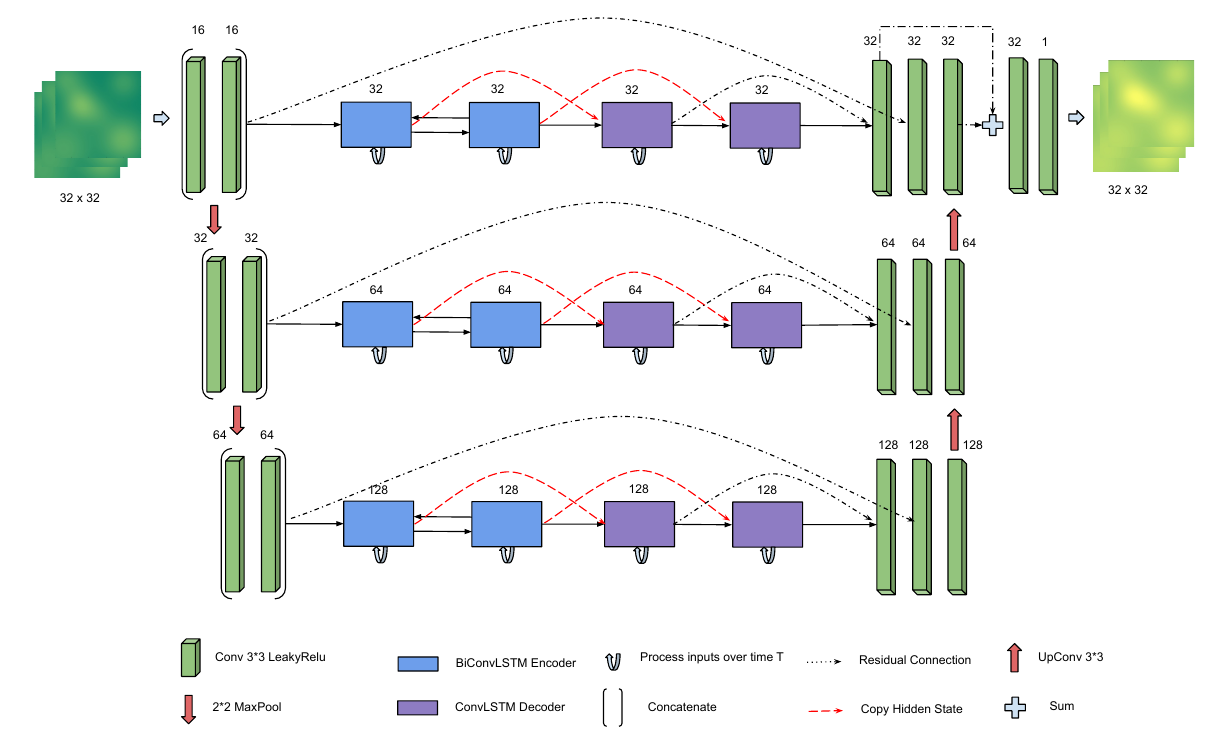
Figure 4. Encoder–decoder architecture with ConvLSTM and residual connections (example for 32 × 32 pixels in the lowest resolution). The encoder consists of the two initial 2D convolution layers that extract the initial features of the input. Subsequently, the BiConvLSTM encoders are deployed to learn the forward and backward correlations over these extracted features of the input sequence. The ConvLSTM decoder then recursively unwraps the hidden features encoded in the hidden state of the encoder, and the 2D convolution layers map it to output predictions. The number of feature maps of each CNN layer is denoted above their respective